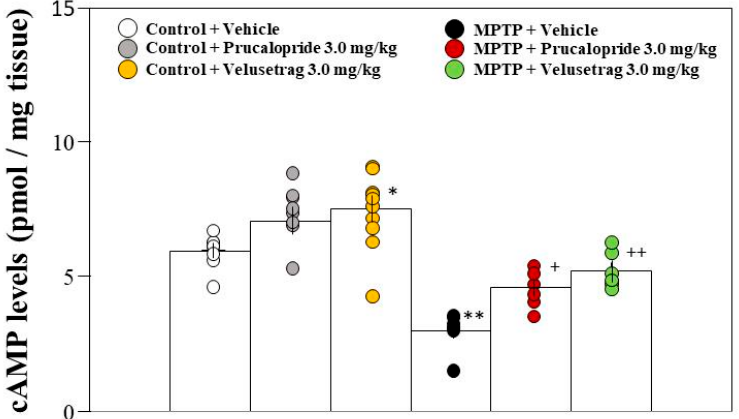
Figure 5. Administration of the 5-HT 4 R agonists to PD mice restored the decrease in cyclic adenosine monophosphate (cAMP) levels in the hippocampus. Mice were given an intraperitoneal injection of prucalopride or velusetrag at a single dose of 3.0 mg / kg in saline containing 1% DMSO or the vehicle only 2 h prior to both extinction training sessions. The hippocampus was collected immediately after the second extinction training. cAMP levels are shown as pmol / mg of trichloroacetic acid (TCA)-precipitated tissue. Data are expressed as the mean ± SEM; n = 7–8. * p < 0.05 and ** p < 0.01 vs. control + vehicle, + p < 0.05 and ++ p < 0.01 vs. MPTP + vehicle (one-way ANOVA followed by Tukey’s post-hoc test).